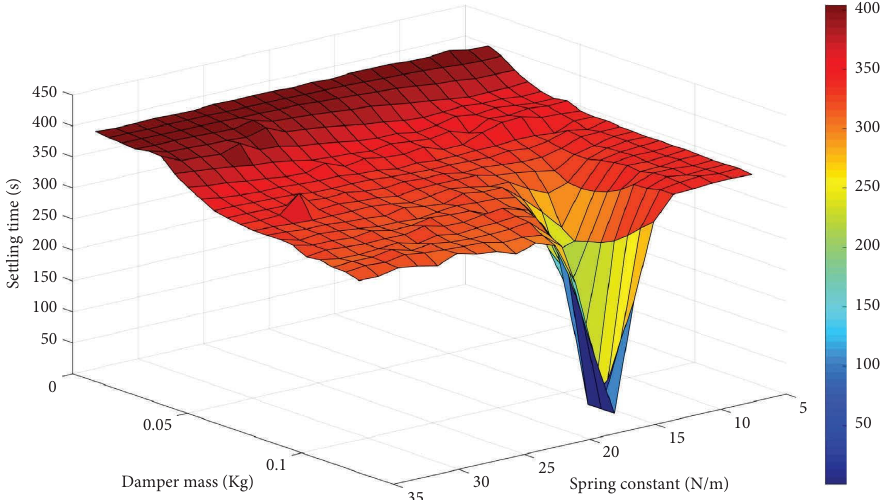
Figure 11: Settling time value for diferent values of m